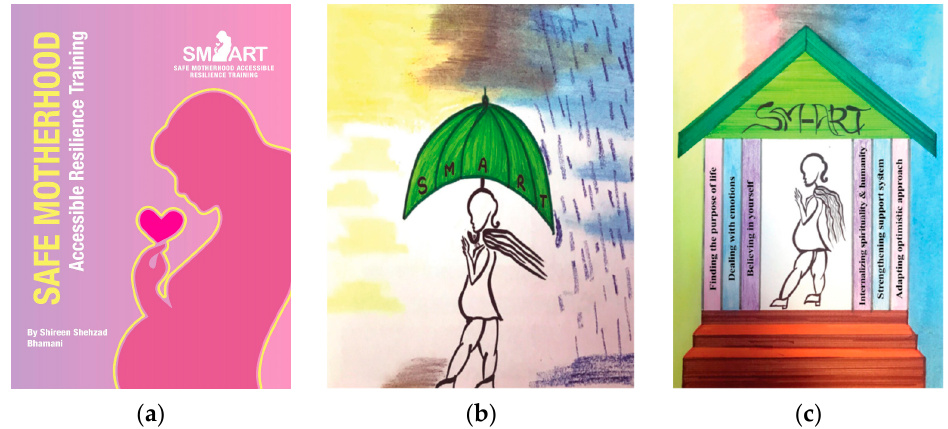
Figure 1. ( a ) The cover page of SMART Intervention; ( b ) The first page of SM-ART intervention; ( c ) The last page of SM-ART intervention.